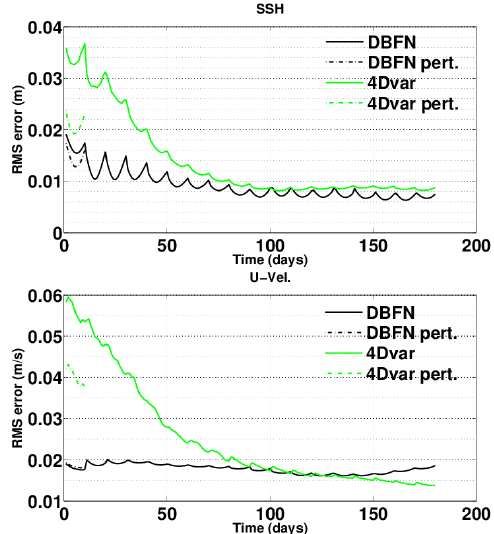
Figure 13. Forecast rms errors in SSH (top panel) and zonal ve- locity (bottom panel) from the DBFN and 4Dvar experiments with DAw of 10 days and assimilating complete daily fields of SSH. Dashed lines concern the results from the perturbed experiments.